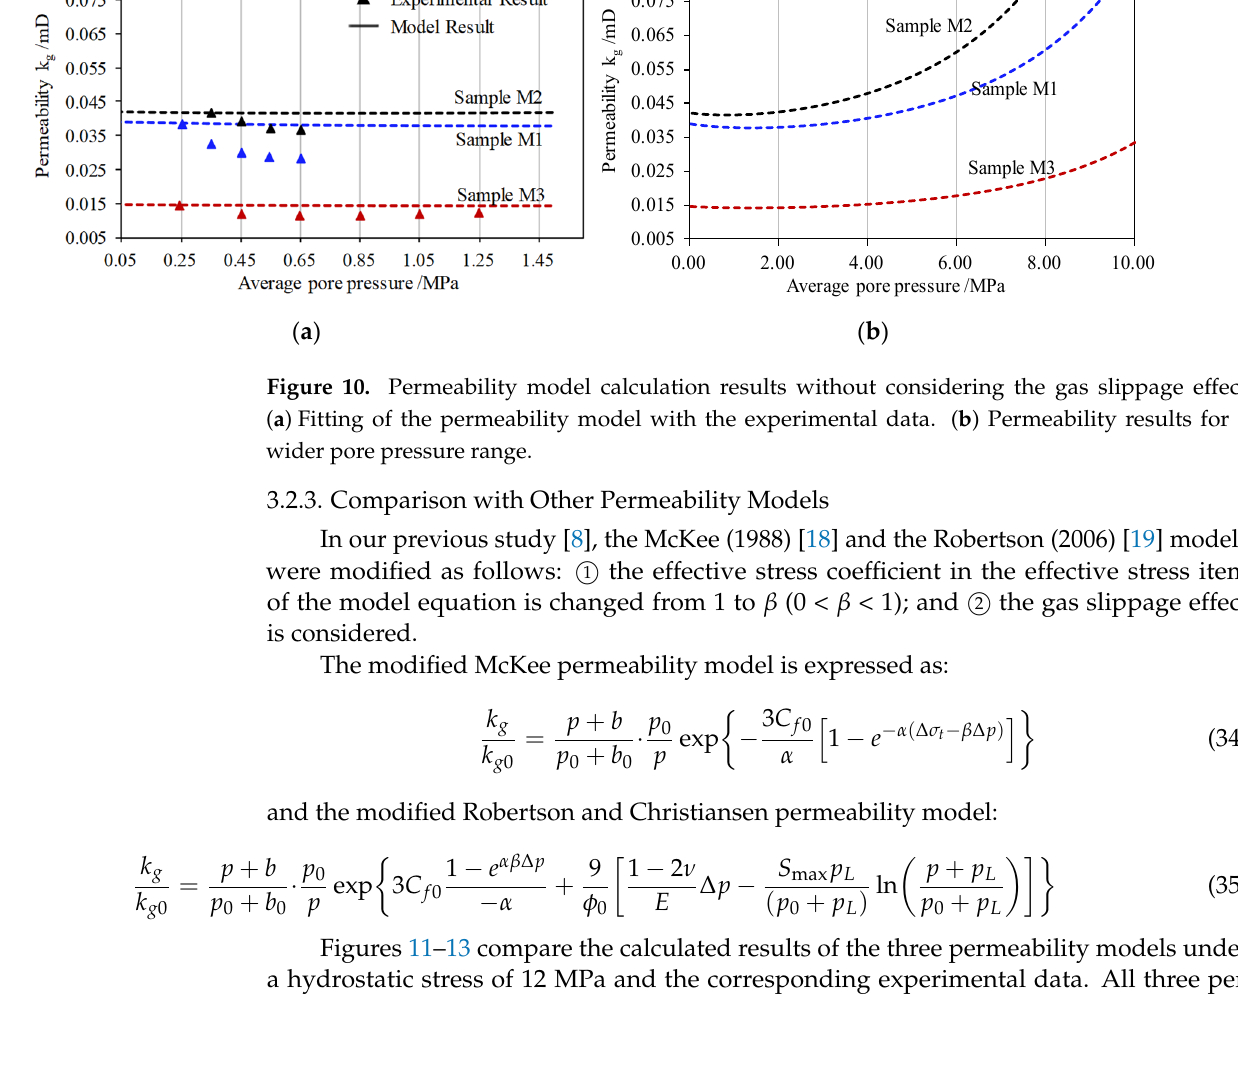
Figure 9. Permeability model calculation results of sample M1 under different hydraulic stresses.